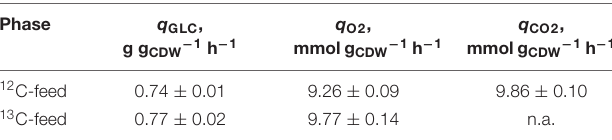
TABLE 3 | Kinetic process parameters from the 13 C-labeling experiment with C. glutamicum ( Figure 7 ) using CGXII minimal medium supplemented with 12